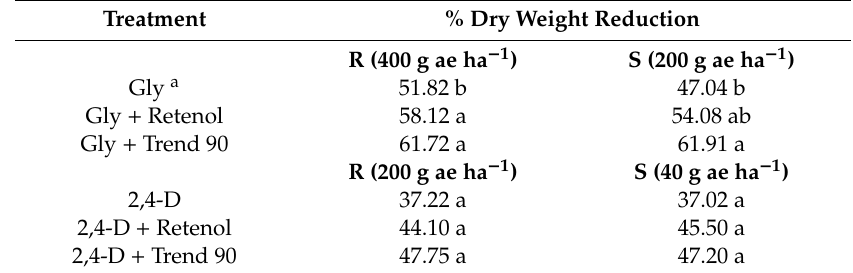
Table 4. E ffi cacy of glyphosate and 2,4-D with and without adjuvants in the R and S populations of C. acanthoides